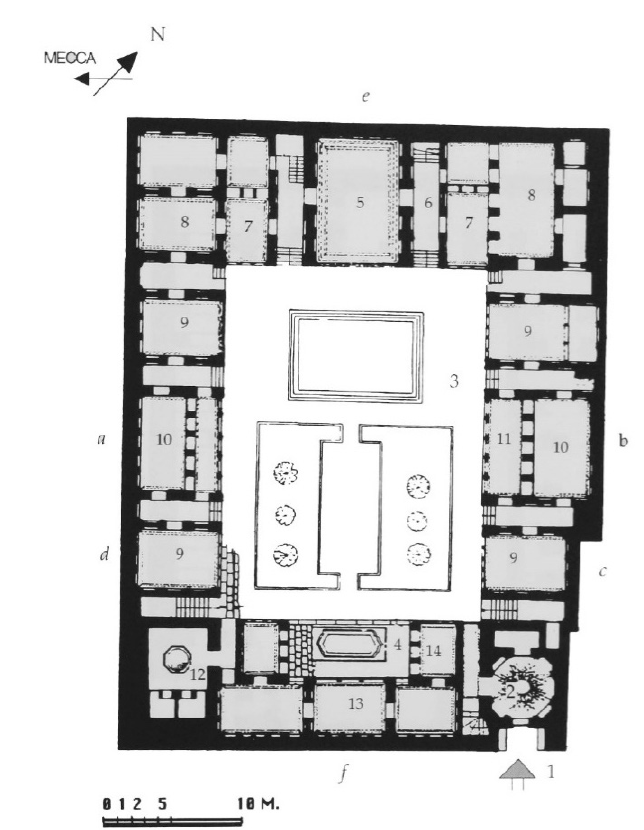
Figure 3. Ground floor plan of Andaruni (private domain) of Qavam house, known as Zinat al-Molk house